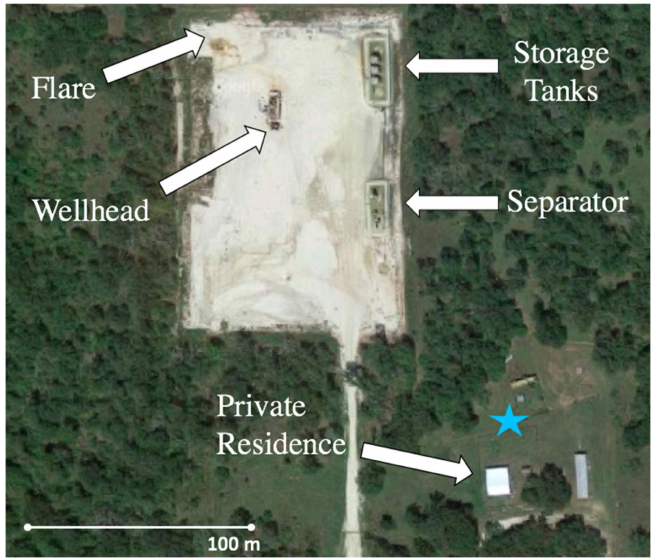
Figure 2. Bird’s eye view of the sampling location (indicated by the blue